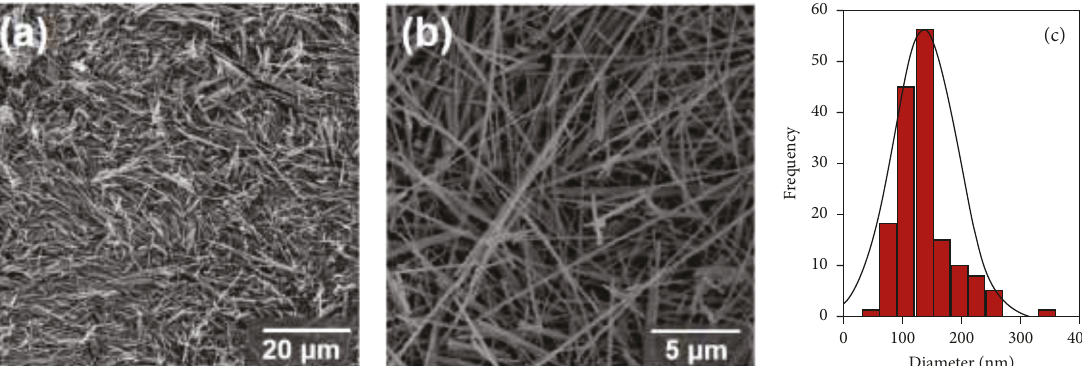
Figure 1: (a) Low and (b) high-magnification SEM images of Ag 2 Mo 3 O 10 .2H 2 O nanorods prepared by the hydrothermal method (magnifications: (a) 2 kx and (b) 10 kx). (c) The diameter size distribution of the nanorods.